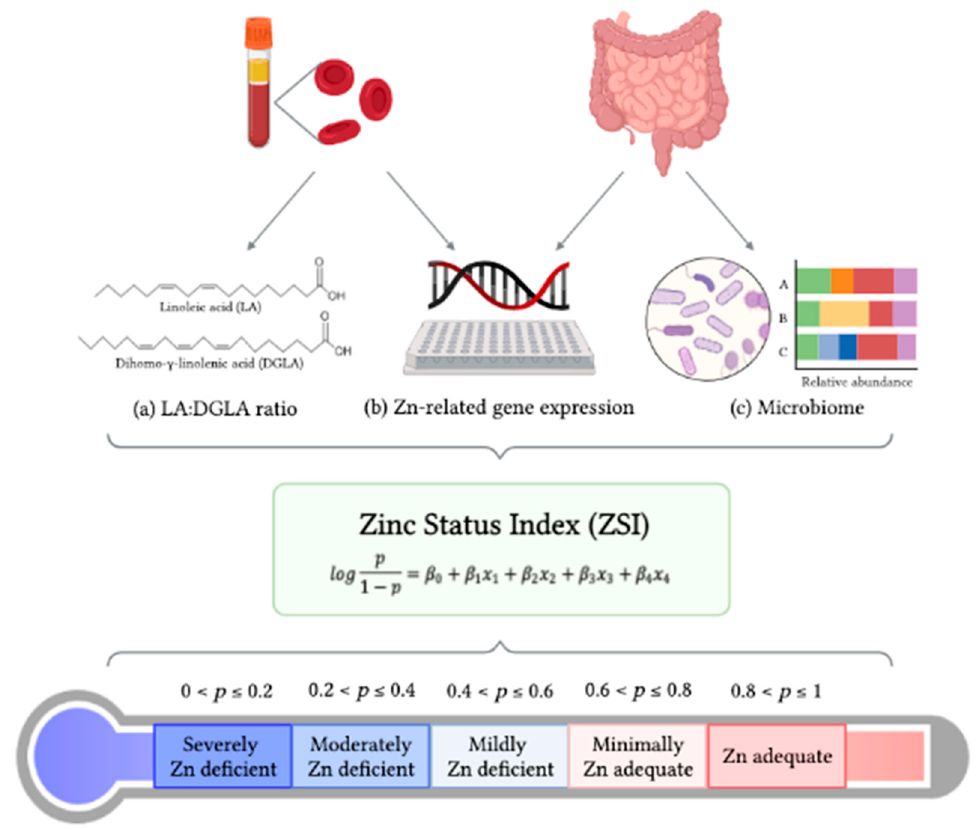
Figure 1. Schematic of ZSI prediction model development. Three pillars, ( a ) LA:DGLA ratio, ( b ) Zn-related gene expression, and ( c ) gut microbiome profile, were utilized for development of the ZSI. Based on our initial ZSI prediction model, we may set preliminary quintiles for Zn status levels based on the predicted probability of Zn adequacy.